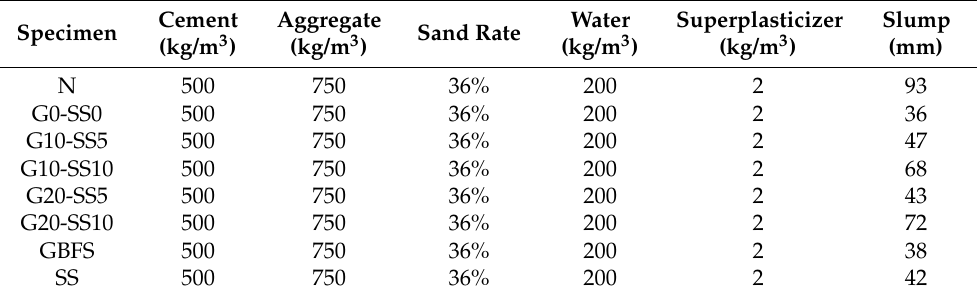
Table 5. The slumps of concrete with different aggregates and modification